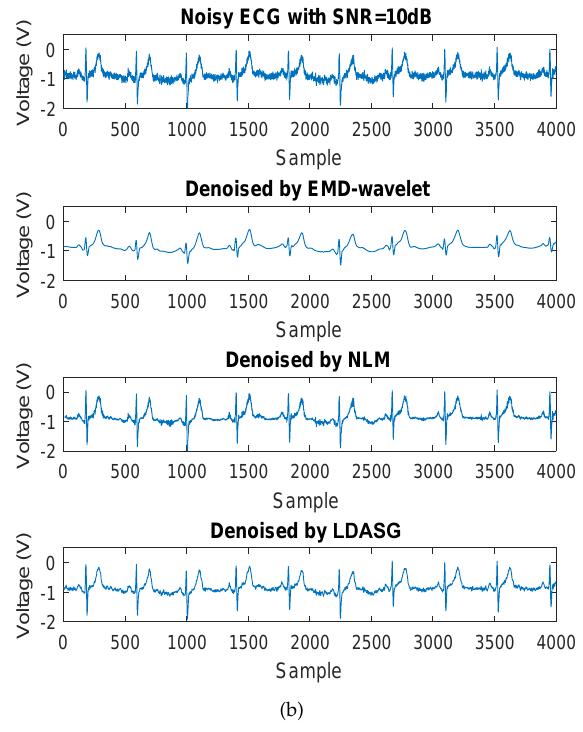
Figure 6. Denoising results comparison of the three methods. ( a ) Results on the noisy ECG signal with the SNR of 0 dB; ( b ) Results on the noisy ECG signal with the SNR of 10